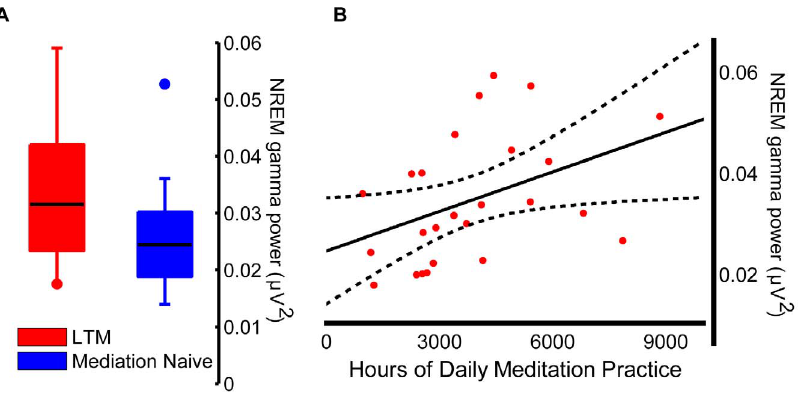
Figure 2. NREM Gamma increase in LTM compared to meditation naives had a large effect size (ES=0.8, Panel A), and was significantly correlated with the length of meditation daily practice (rho=0.475, p=0.017, Panel B).